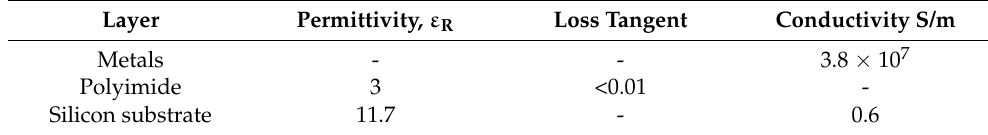
Figure 8. Isolation technology SEM: ( a ) thick-oxide technology. Reproduced from [9]. Copyright 2018, IEEE; ( b ) polyimide technology. Reproduced from [7]. Copyright 2020, IEEE. Table 1. Main process stack parameters for polyimide isolation technology.